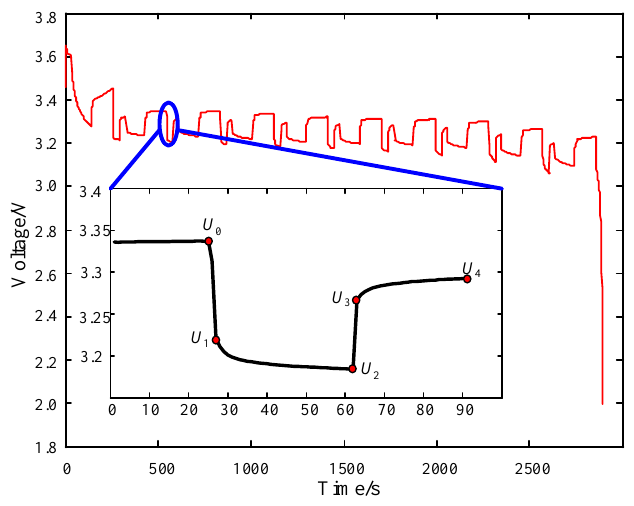
Figure 3. Lithium battery discharge curve.